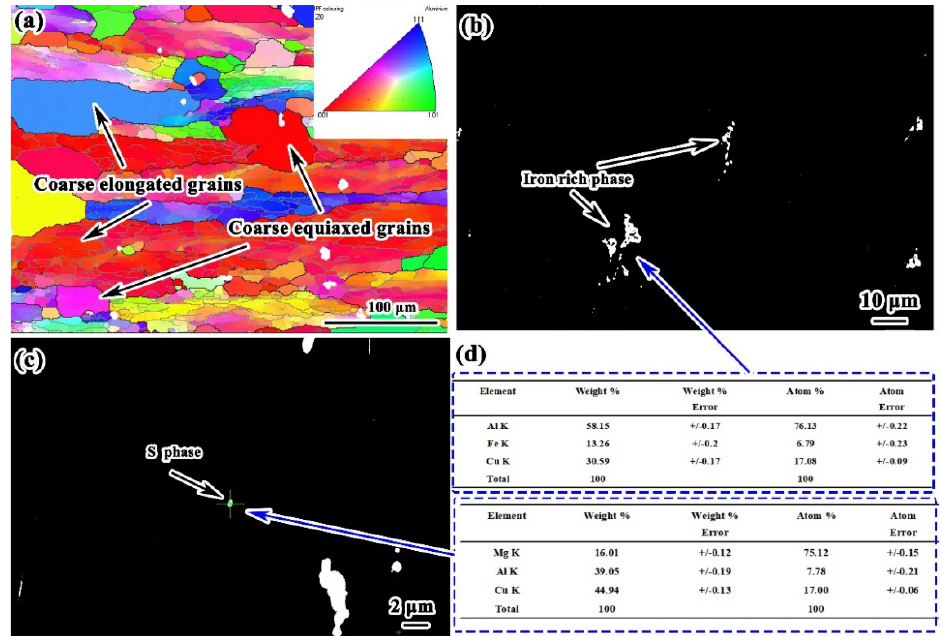
Figure 2. Microstructure of 7055sq: ( a ) EBSD image; ( b ) SEM for iron rich phase; ( c ) SEM for S phase; ( d ) EDS